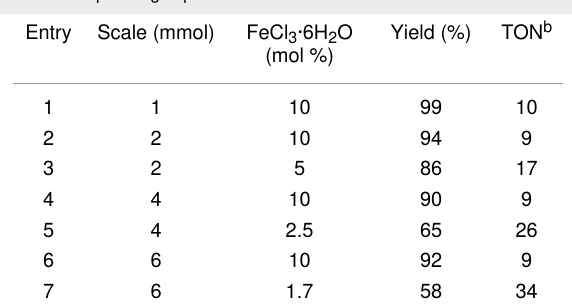
Table 3: Upscaling experiments a